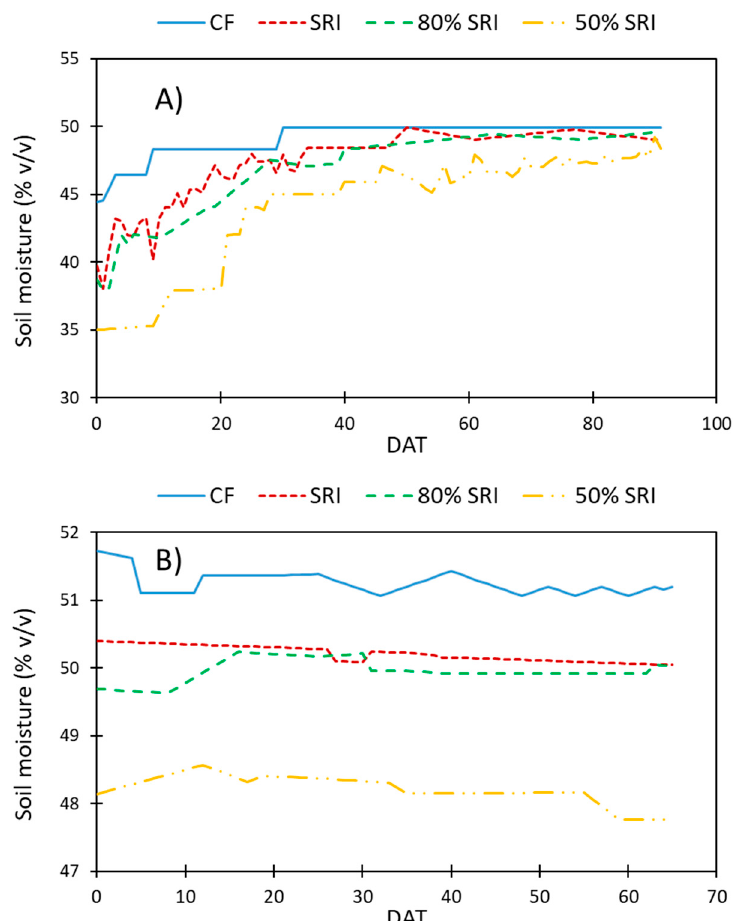
Figure 6. ( A ) Dry season (October 2012 to January 2013) and ( B ) wet season (February 2013 to June 2013) daily average soil moisture below the root zone (60 cm) against days after transplanting (DAT). The CF is continuous flooding, SRI is system of rice intensification, and 80% SRI and 50% SRI refers to 80% and 50% of the SRI ponding depth, respectively.